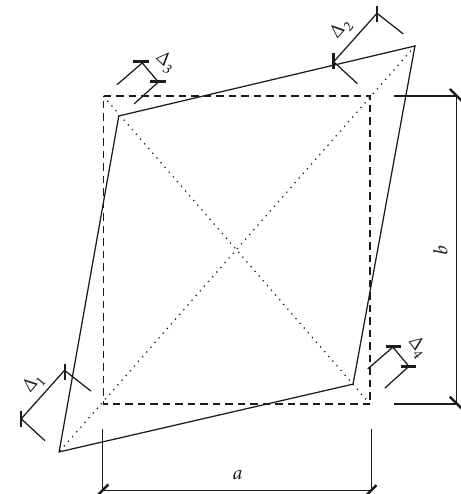
Figure 7: Calculation of the joint shear deformation angle c